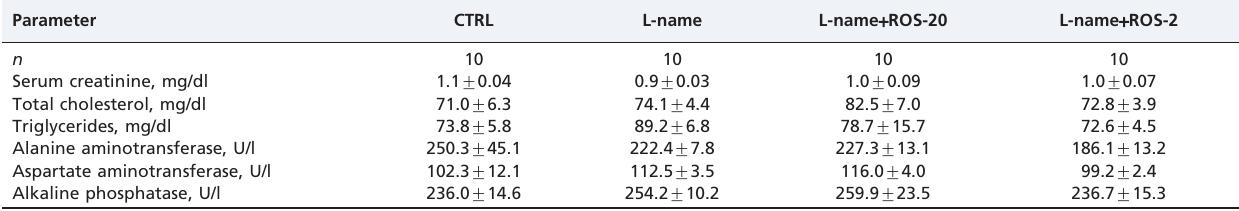
Table 1 - Biochemical parameters of the experimental groups at the end of the experiment. Parameter CTRL